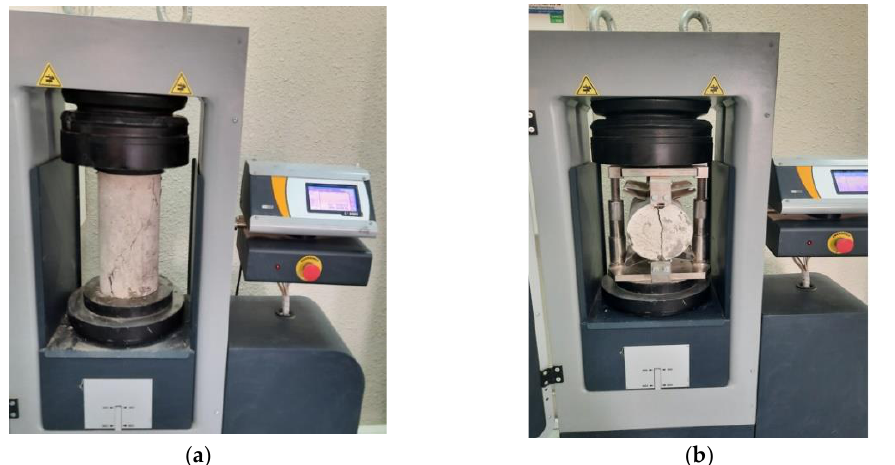
Figure 12. Measuring the mechanical properties of concrete. ( a ) Compressive strength; ( b ) Splitting tensile strength.